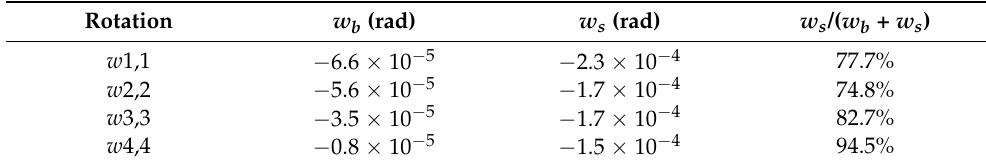
Table 4. Comparison of the rotations in the FEM